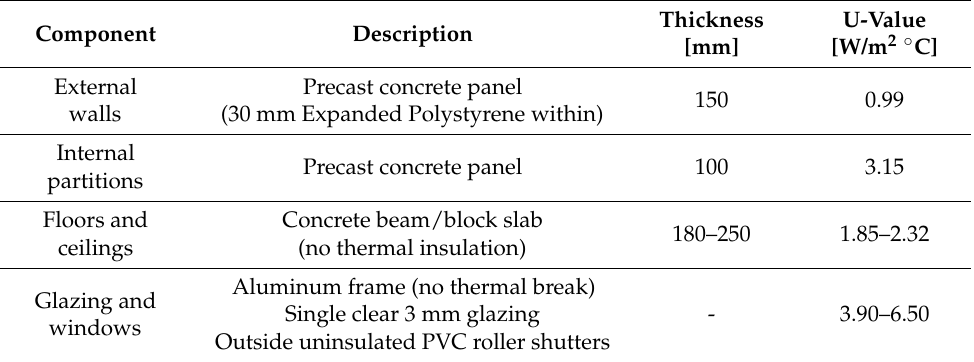
Table 2. Building general constructive characteristics.